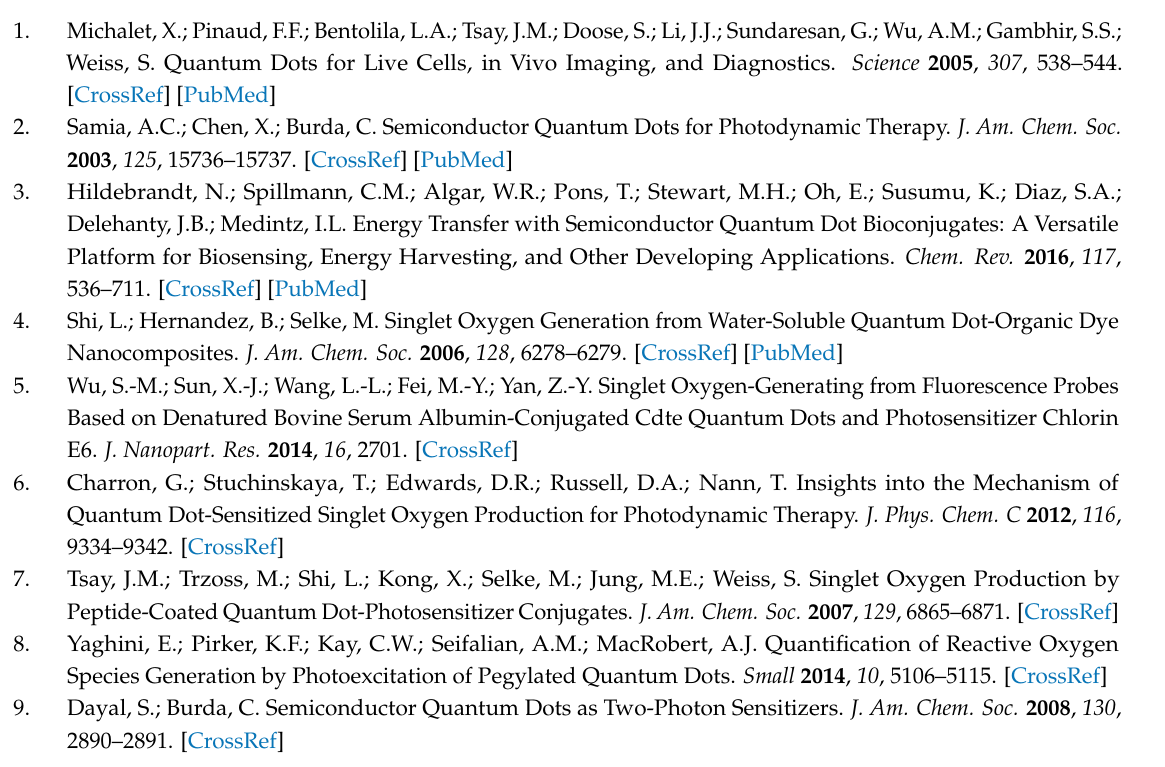
Figure S1: Absorption and emission spectra of L - and P -QDs, Figure S2: Fluorescence excitation spectrum of Ce 6 , Figure S3: Change of L - and P -QD-Ce 6 PL signals with time, Figure S4: R 0 , r values vs n and κ 2 , and schematic representation of QD-Ce 6